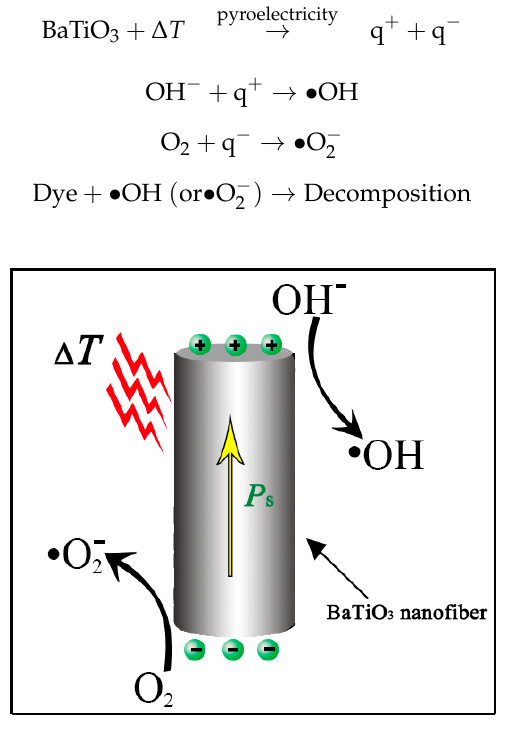
Figure 5. The principle scheme of pyro-electro-chemical catalysis of pyroelectric materials under thermal cycle excitations.